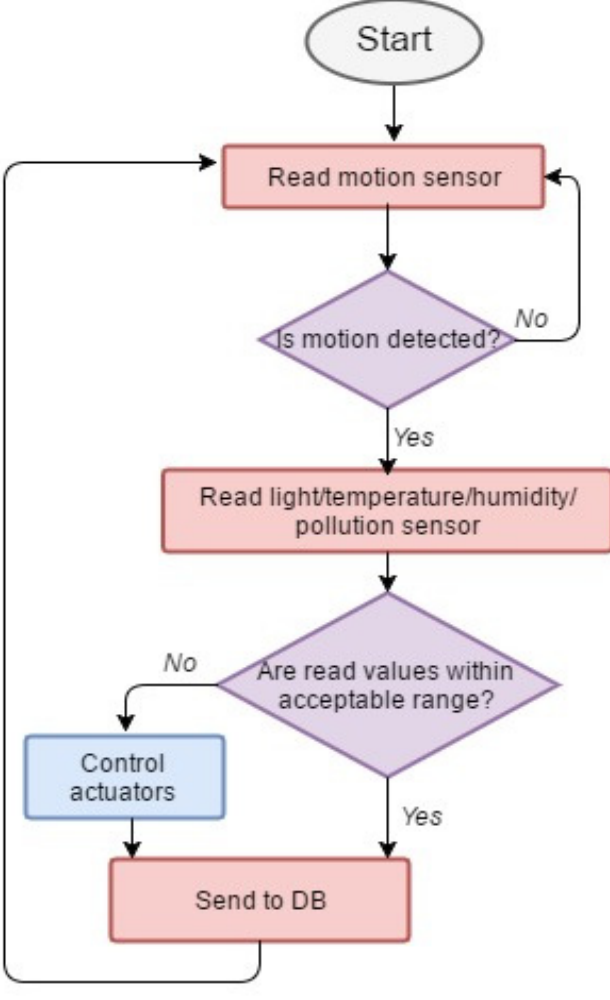
Figure 2. Flowchart of the control and processing layer.